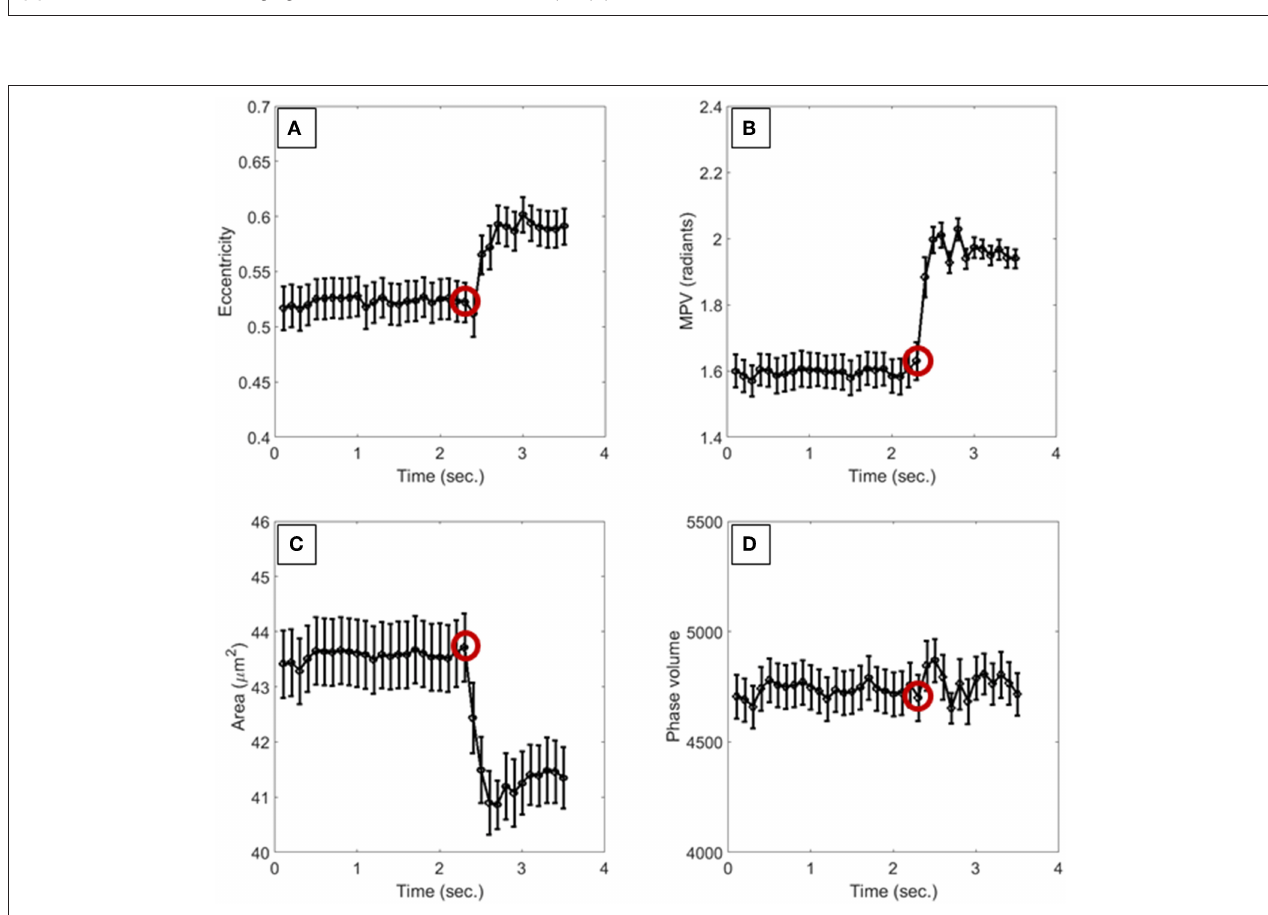
FIGURE 4 | Morphological metrics used to monitor the biomechanical deformation of RBCs. (A) is the eccentricity, (B) reports the MVP, (C) is the surface area, and (D) measures the phase volume. The red circles highlight the instant of time in which the pump pressure starts to work. All values are averaged over the total number of cells, and the corresponding standard deviations are reported as error